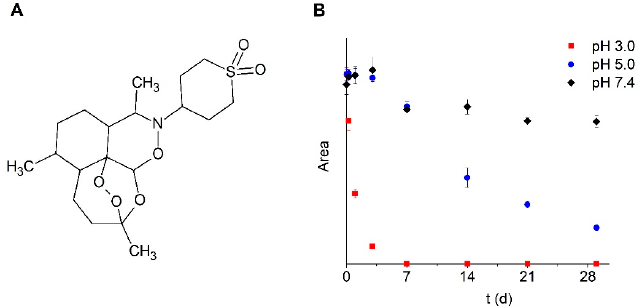
Figure 1. ( A ) Chemical structure of artemisone and ( B ) impact of pH on stability of artemisone in aqueous media, measured with